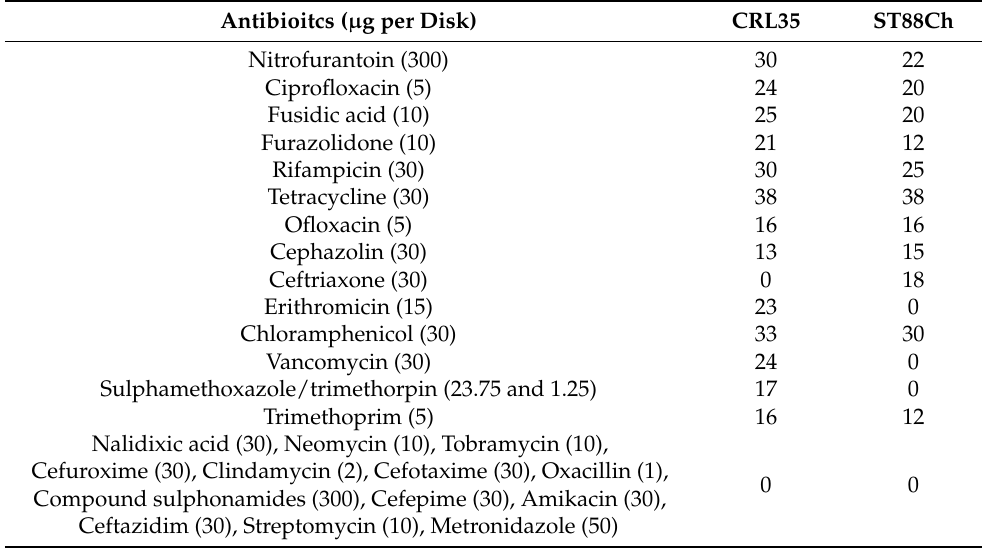
Table 1. Effect of selected antibiotics on the growth of E. mundtii CRL35 and E. faecium ST88Ch. Results are expressed as the size of inhibition zones in